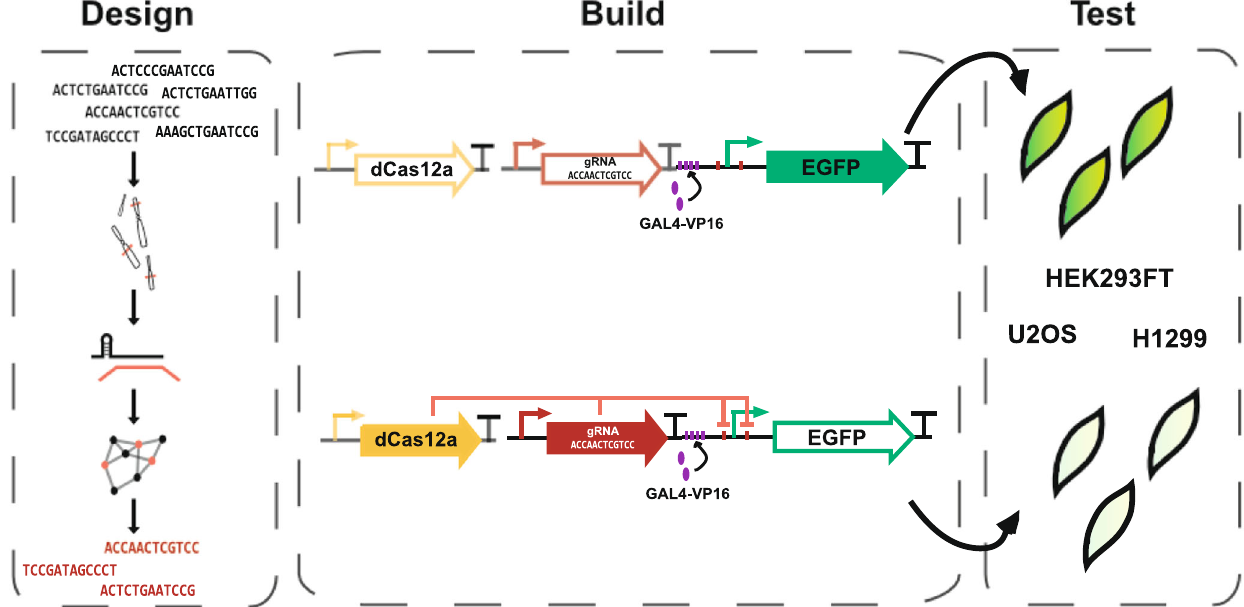
Fig. 1 Framework of the study. gDesigner enables the automated selection of orthogonal gRNAs with minimized off-target effects and promoter crosstalk. We generated a library of orthogonal synthetic dCas12a-repressed promoters that downregulates target gene expression by means of steric hindrance of the cognate promoter. We tested the library in HEK293FT, U2OS and H1299 cells